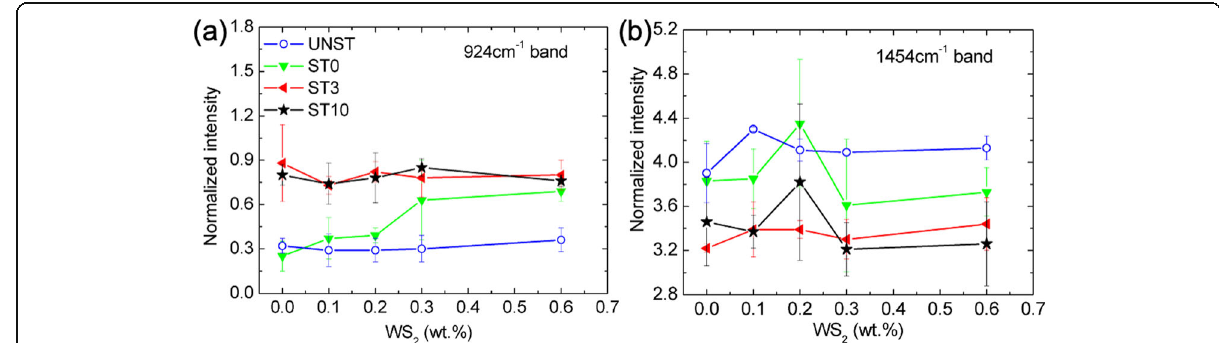
Fig. 7 Normalized Raman intensity of 924 cm − 1 and 1454 cm − 1 PLA bands measured in the spectra of UNST, ST0, ST3, ST10 films of PLA and PLA-WS 2 nanocomposites. The data are normalized with respect to the intensity of the PLA band at 1095 cm −